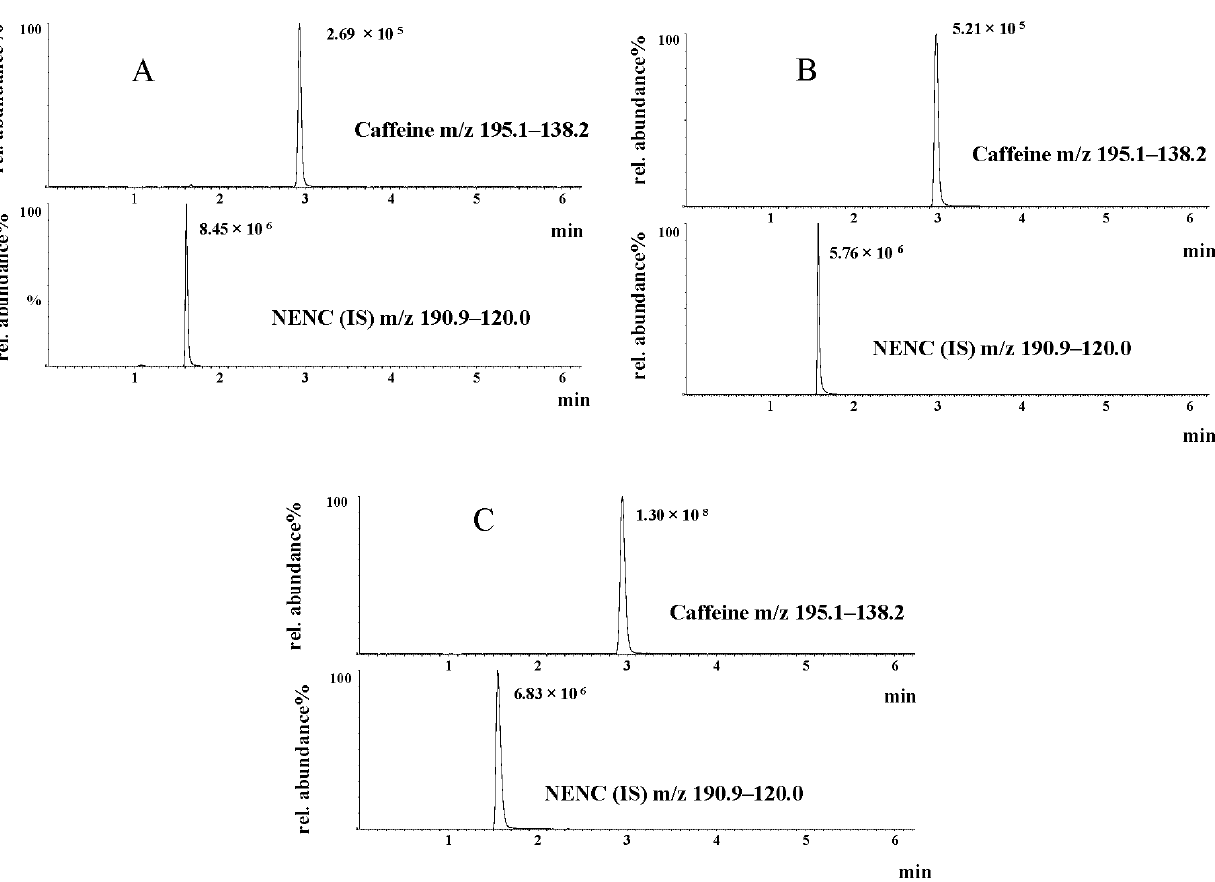
Figure 1. UPLC-MS/MS chromatograms obtained following the extraction of a urine sample containing 11.8 ng/mL caffeine ( A ), a cotton swab sample containing 27.2 ng/swab ( B ) and textile sample containing 17.2 µg/sample ( C